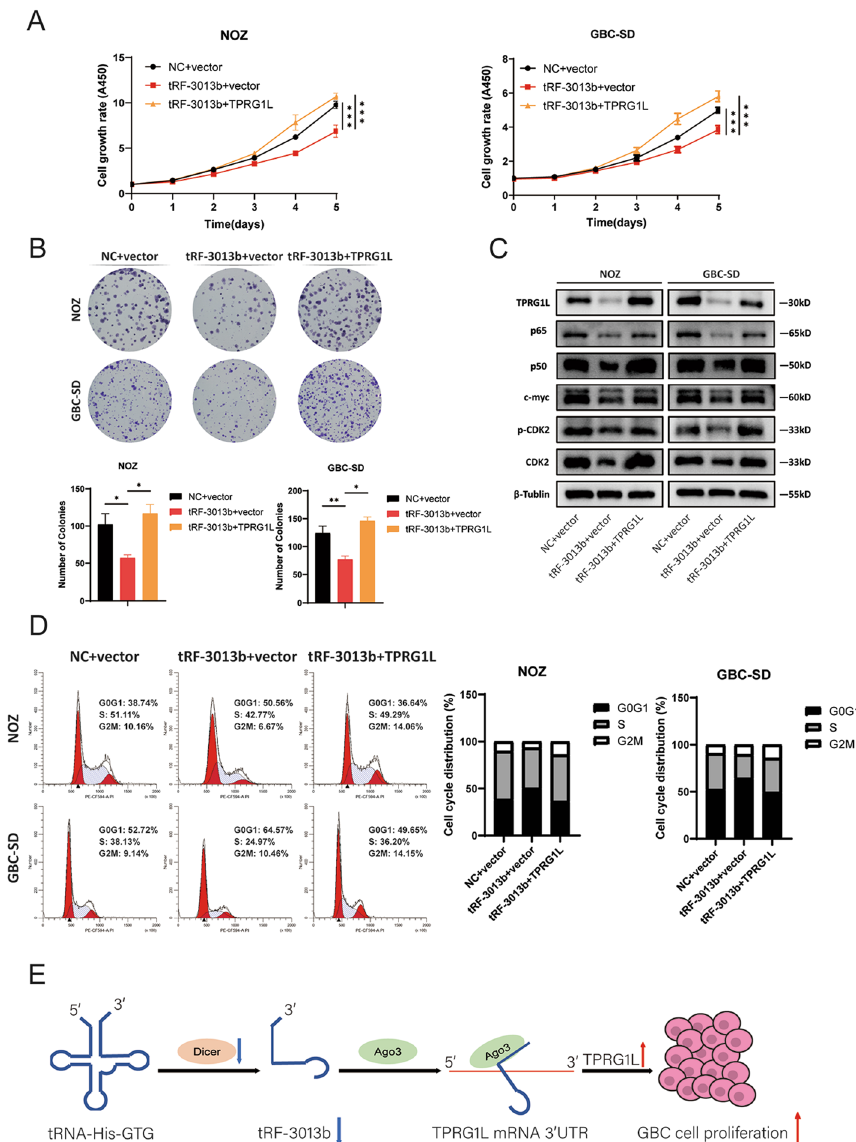
Fig. 6 Overexpression of TPRG1L rescued the inhibitory effects of tRF-3013b. A CCK8 assay and B colony formation were performed to evaluated cell proliferation capacity after cotransfection of NOZ and GBC-SD with NC or tRF-3013b mimic and vector or TPRG1L. C Relative protein expression of TPRG1L, p65, p50, c-myc, CDK2, and p-CDK2 after cotransfection of NOZ and GBC-SD with NC or tRF-3013b mimic and vector or TPRG1L. D Cell-cycle assay was evaluated after cotransfection of NOZ and GBC-SD with NC or tRF-3013b mimic and vector or TPRG1L. E Schematic depiction of the function and potential mechanism of tRF-3013b in GBC. * P < 0.05, ** P < 0.01, *** P <